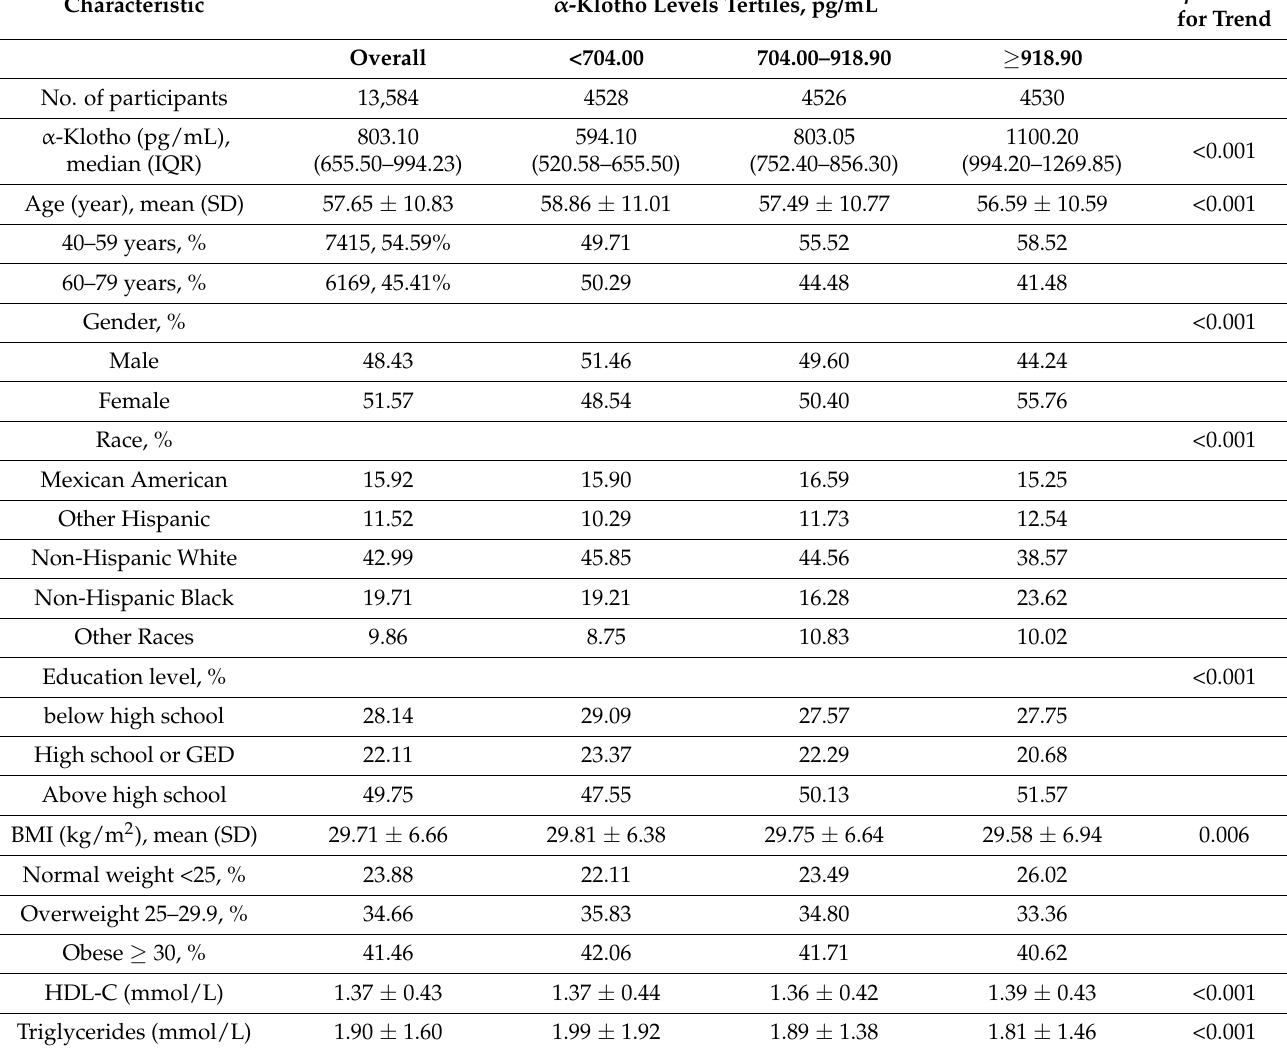
Table 1. Baseline characteristics of the study population according to α -Klotho tertiles (n = 13,584). Characteristic α -Klotho Levels Tertiles, pg/mL